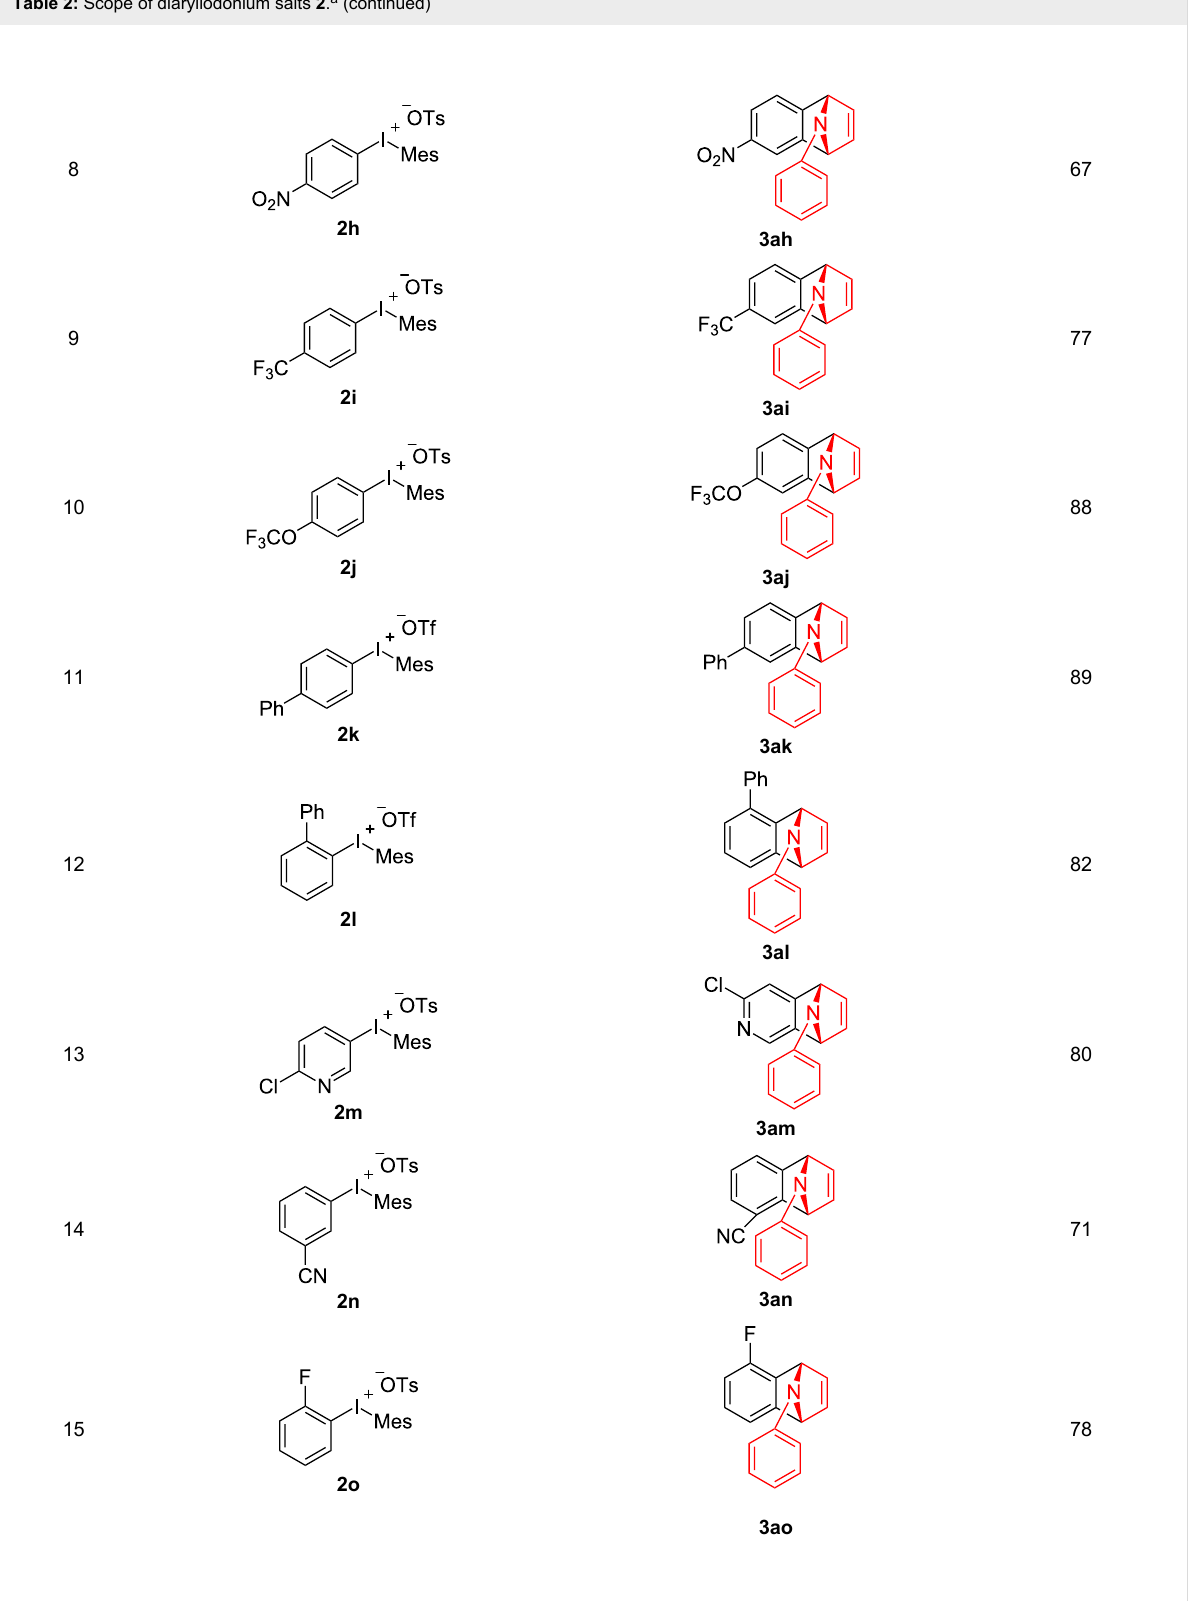
Table 2: Scope of diaryliodonium salts 2 . a